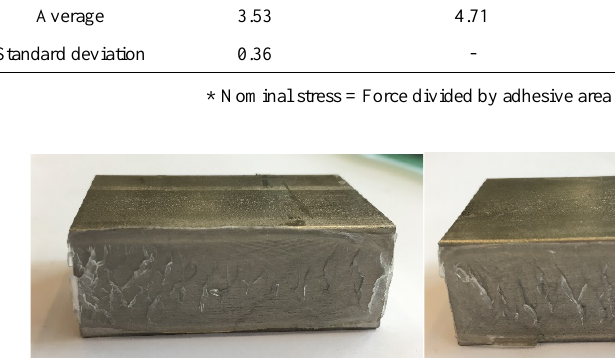
Fig. 9 TSSA laminated connections on the glass edge after